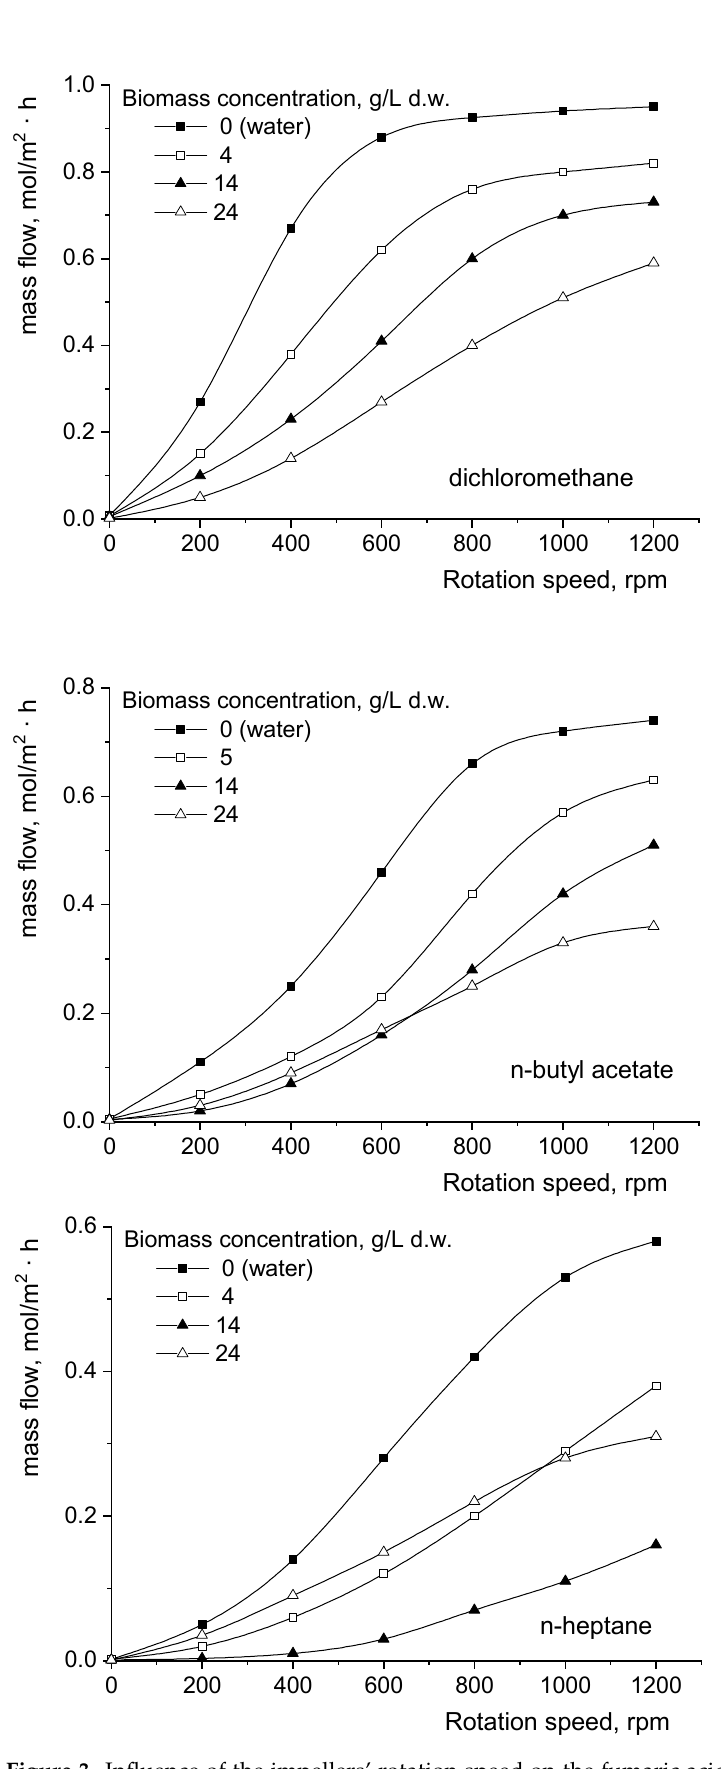
Figure 3. Influence of the impellers’ rotation speed on the fumaric acid mass flow from Rhizopus oryzae suspensions to the organic phase without 1 ‐ octanol.